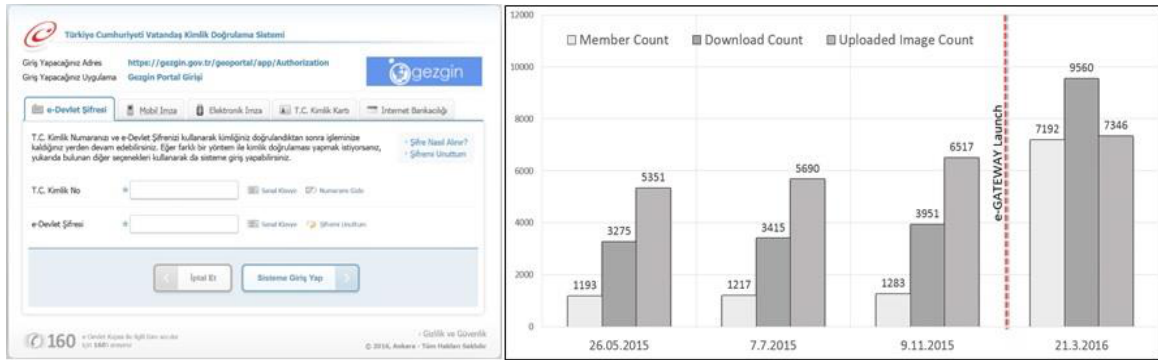
Figure 1. GEZGIN Portal e-Government login screen (left) and user statistics